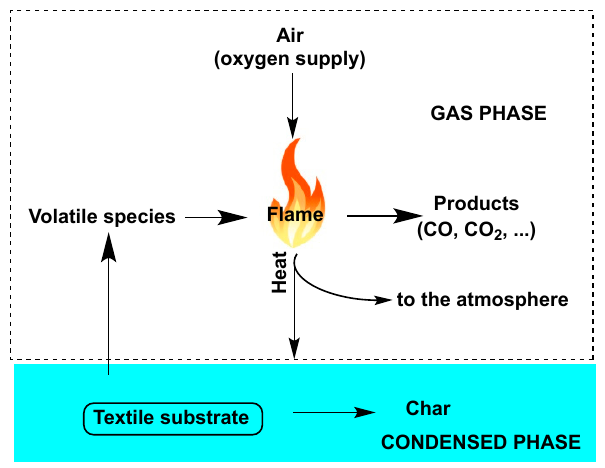
Figure 1. Scheme of the textile combustion cycle.